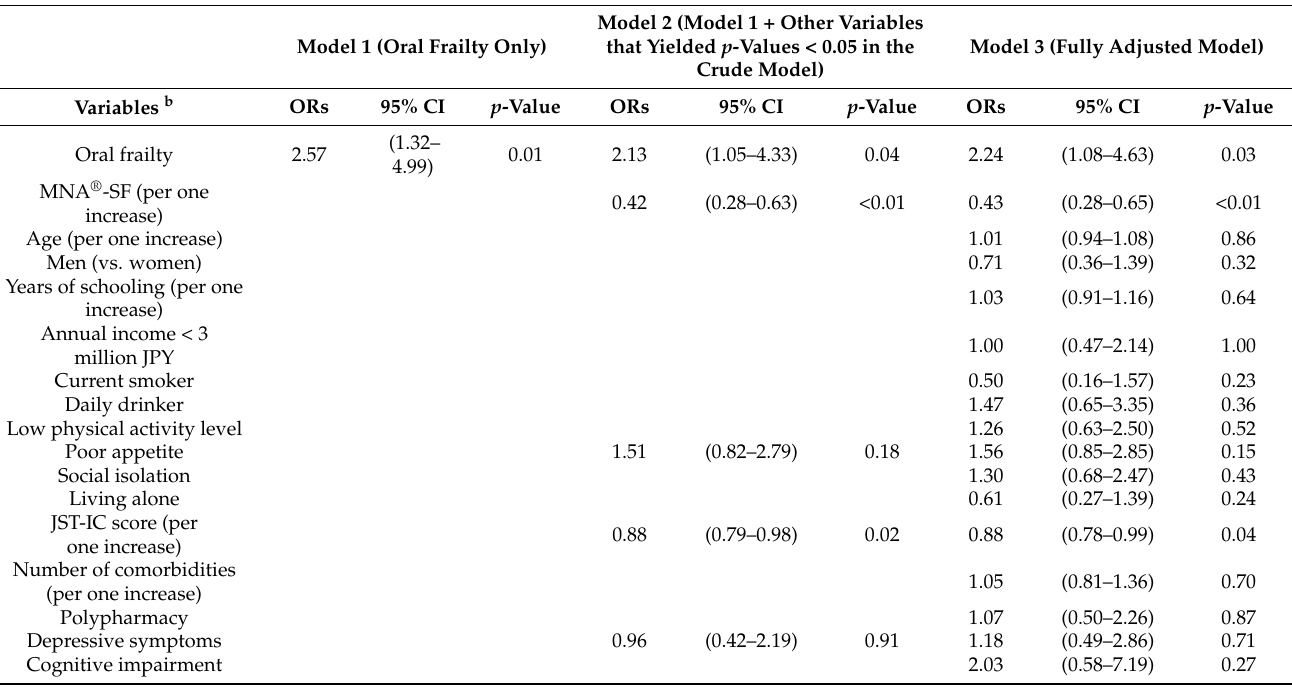
Table 4. Three logistic regression models for the association between oral frailty and deteriorating nutritional status based on the MNA ® -SF score a